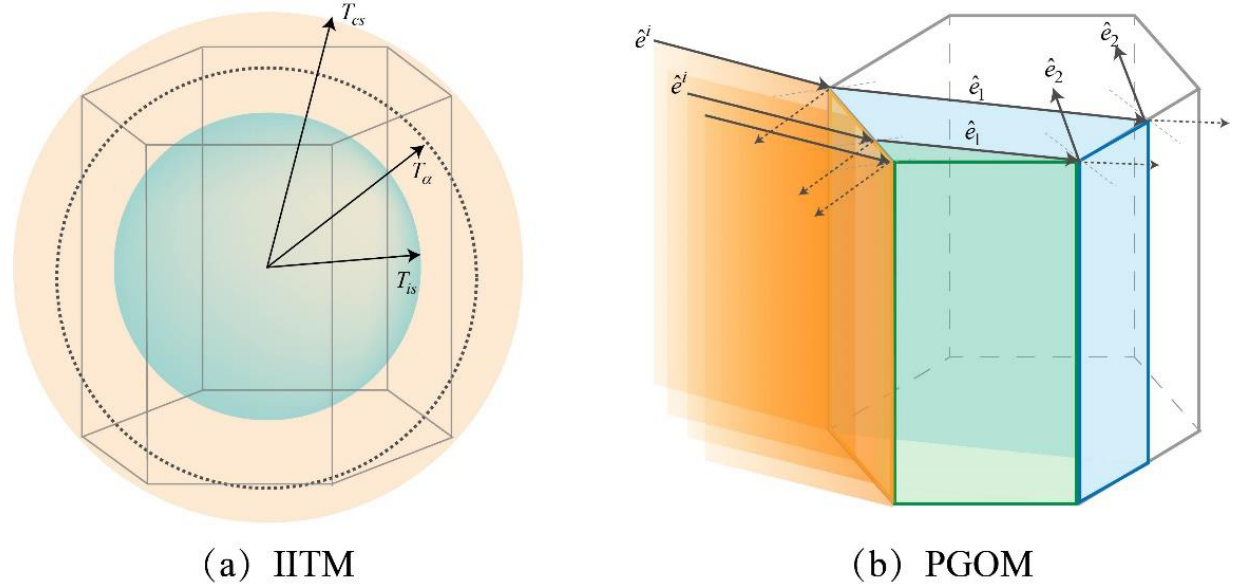
Figure 3. ( a ) Schematic view of the invariant imbedding T-matrix method. T is and T cs represent the T-matrix of the inscribed and circumscribed spheres, respectively. T α denotes the α -th step iteration of T-matrix. ( b ) An example of beam-splitting in the physical-geometric optics method. ˆ e i denotes the incident beam; ˆ e 1 is the initial refracted beam and was divided into two parts (green and blue shades); and ˆ e 2 indicates secondary refracted beam. The dashed lines show the reflected-refracted beams exiting the particle.